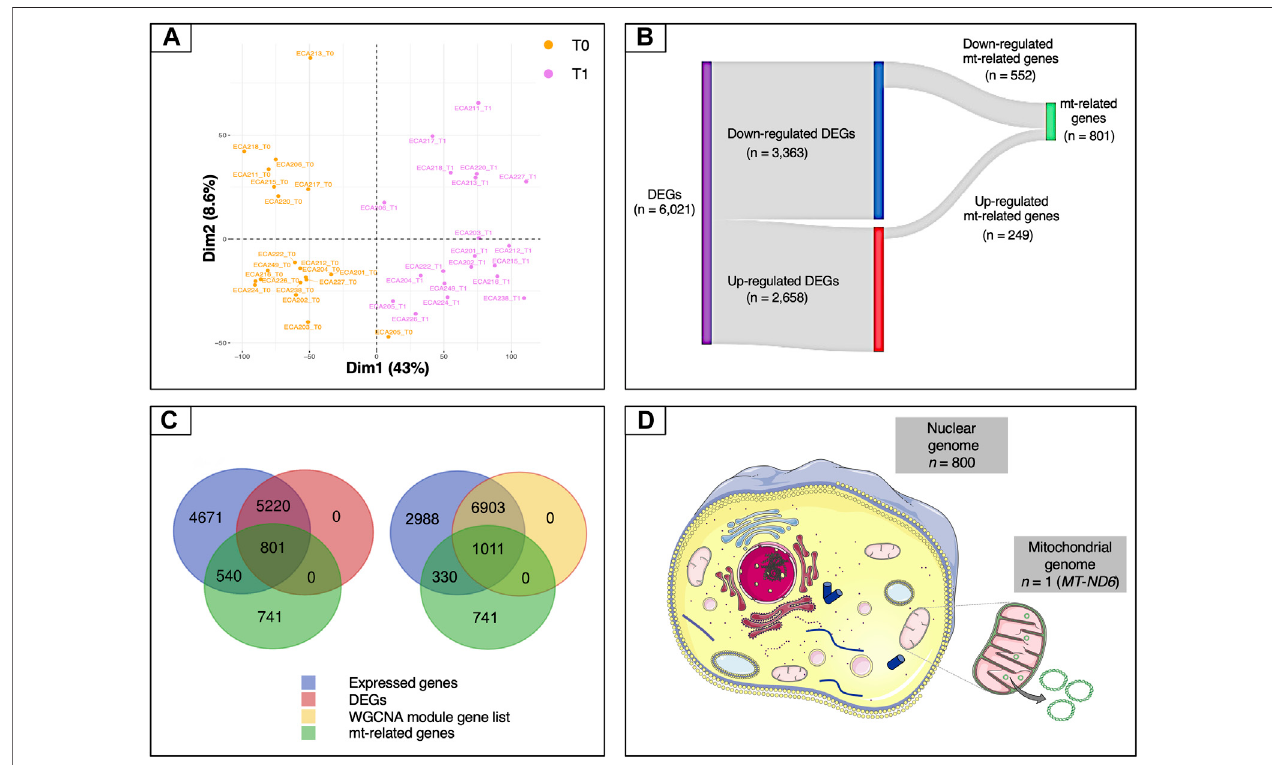
FIGURE2| Overviewofthemt-relatedgenes. (A) Plotofthe fi rsttwocomponentsofthePCAobtainedusingalloftheexpressedgenes. (B) Sankeydiagramofthe differentially expressed genes, showing thenumbers ofup-regulated, down-regulated and mt-related genes. Only arelatively small fraction ofthemt-relatedgenes (249 out of 801) was up-regulated, whereas most (552 out of 801) were down-regulated. (C) Venn diagrams illustrating the overlaps among expressed genes (blue), differentially expressed genes (purple), genes included in WGCNA modules (yellow) and mt-related genes (green). (D) Illustration of the proportion of mt-related genes encoded by the mitochondrial and by the nuclear genomes. Except for MT-ND6 , all of the other genes are encoded by the nuclear genome. Data information: in panel D, the picture of the mitochondria was download from https://smart.servier.com. In all cases, no changes were made. Servier Medical Art by Servier is licensed under a Creative Commons Attribution 3.0 Unported